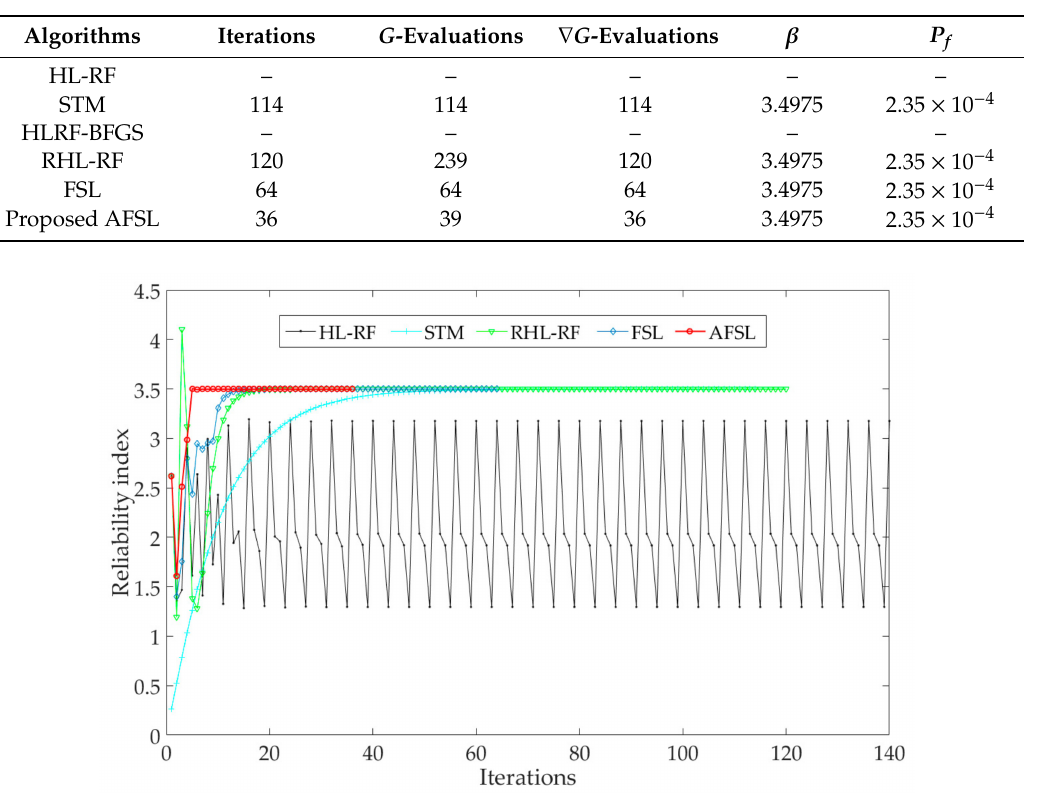
Table 3. Results of di ff erent algorithms for Example 3.